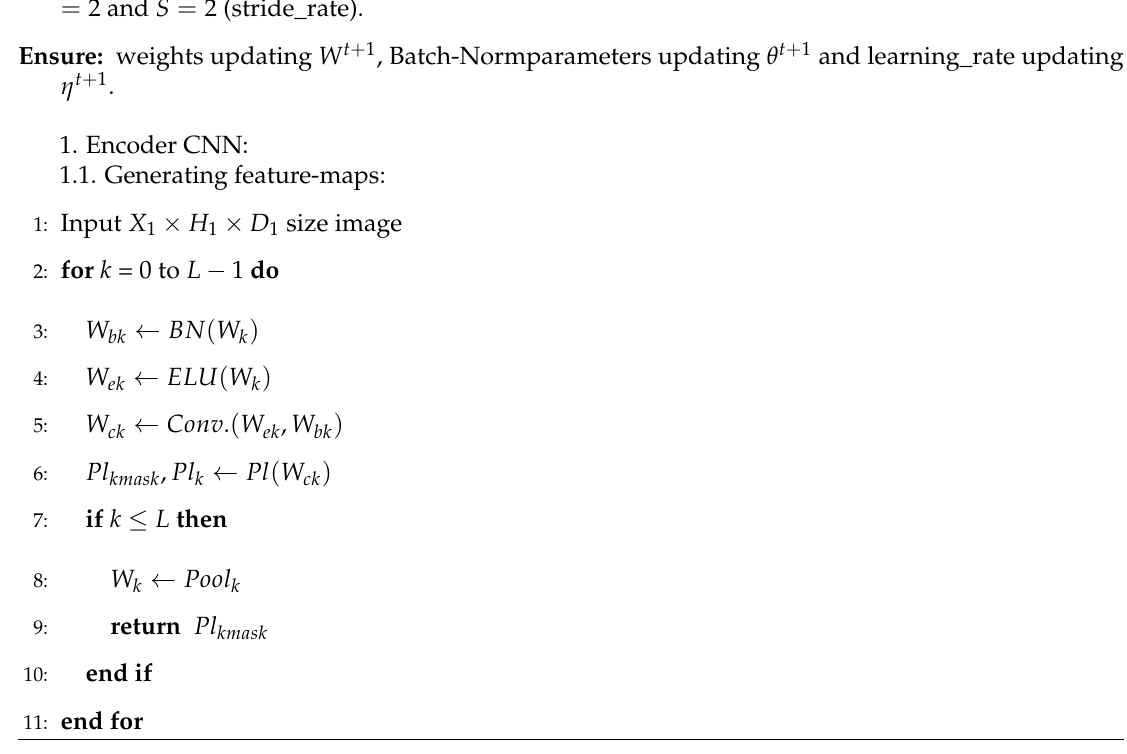
Algorithm 1 CNN encoder training: Training starts with X 1 × H 1 × D 1 . Additional parameters required in training are F spatial extent, K number of filters, P zero padding and S stride rate. The network outputs an image of X 2 × H 2 × D 2